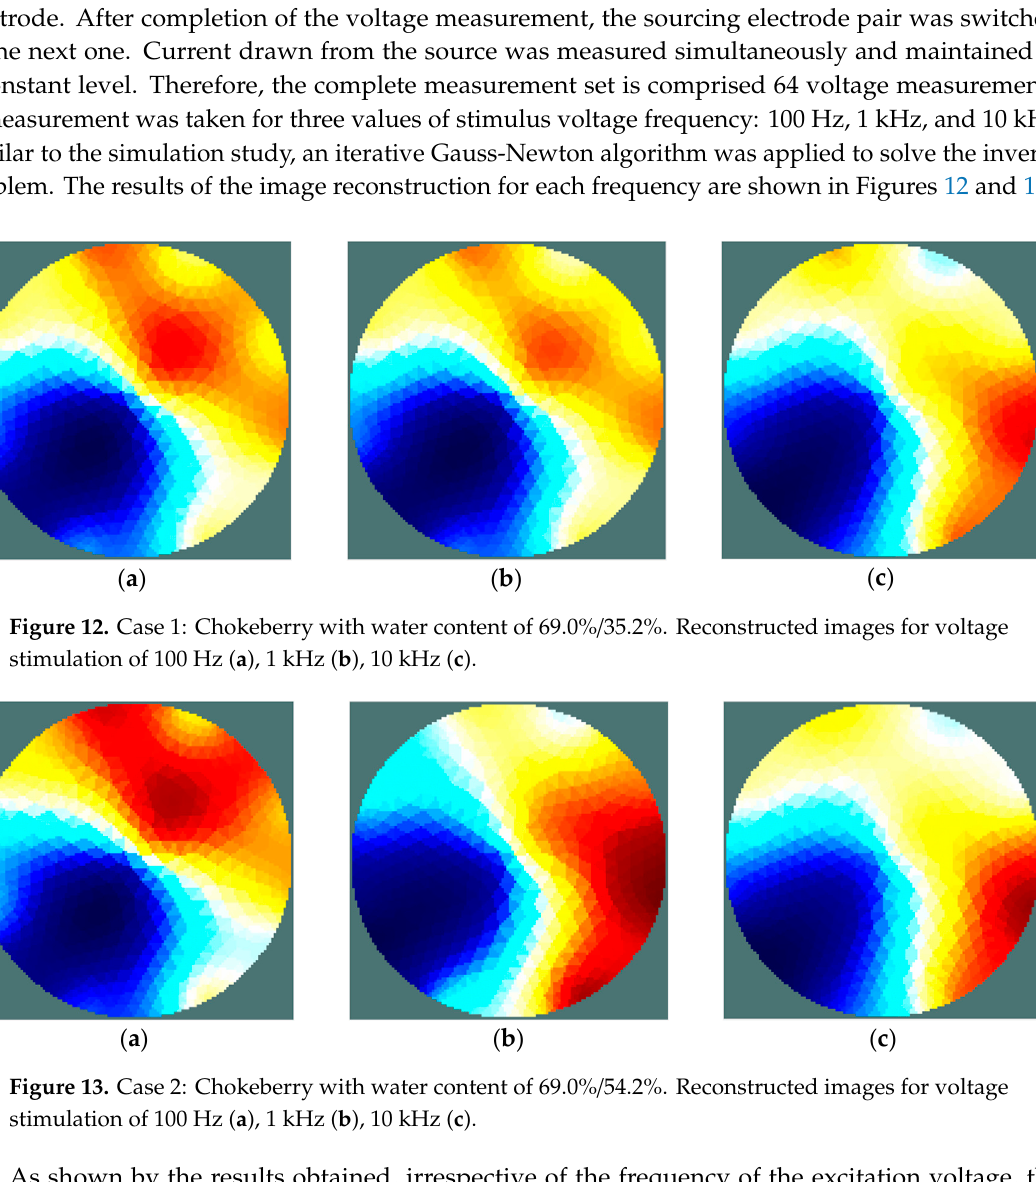
( c ) Figure 11. Distinguishability analysis: 16-electrode sensor, regions too close—finite element grid ( a ) and image reconstructed using simulated data for the normal grid ( b ) and dense grid ( c ). 3.3. Imaging of the Spatial Distribution of Moisture Content in the Chokeberry—Image Reconstruction Based on Experimental Data Experimental verification of the simulation results was performed using the measurement